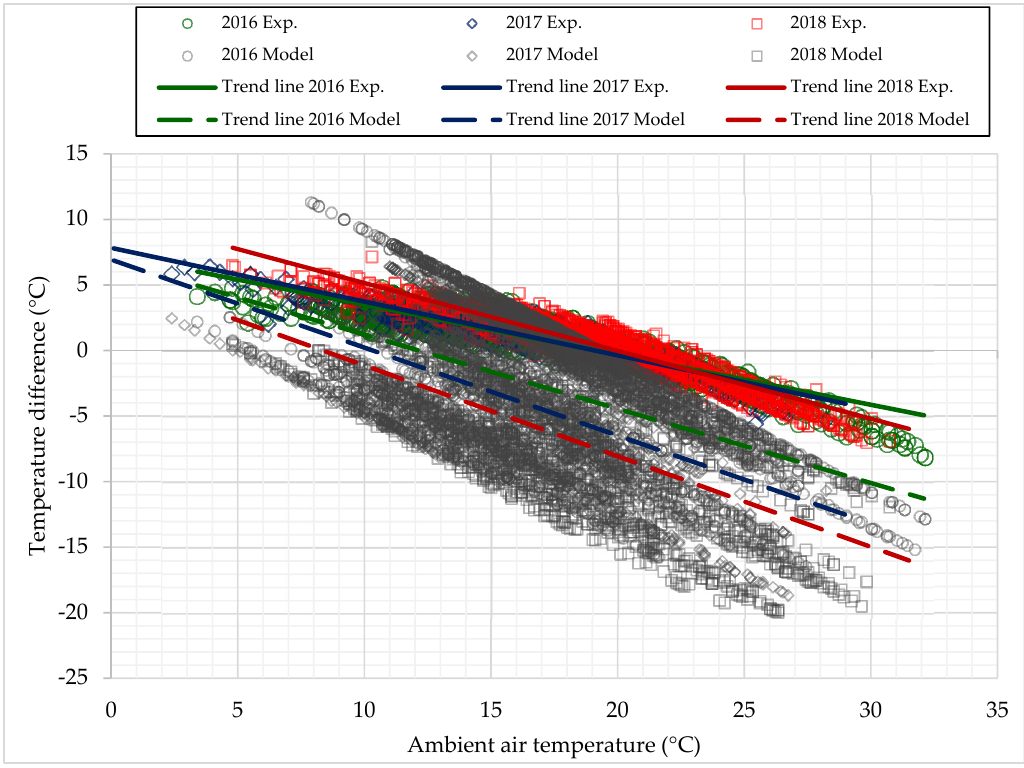
Figure 5. Differences in air temperature between the GAHE inlet and outlet (real-world and modeled data) relative to ambient air temperature.